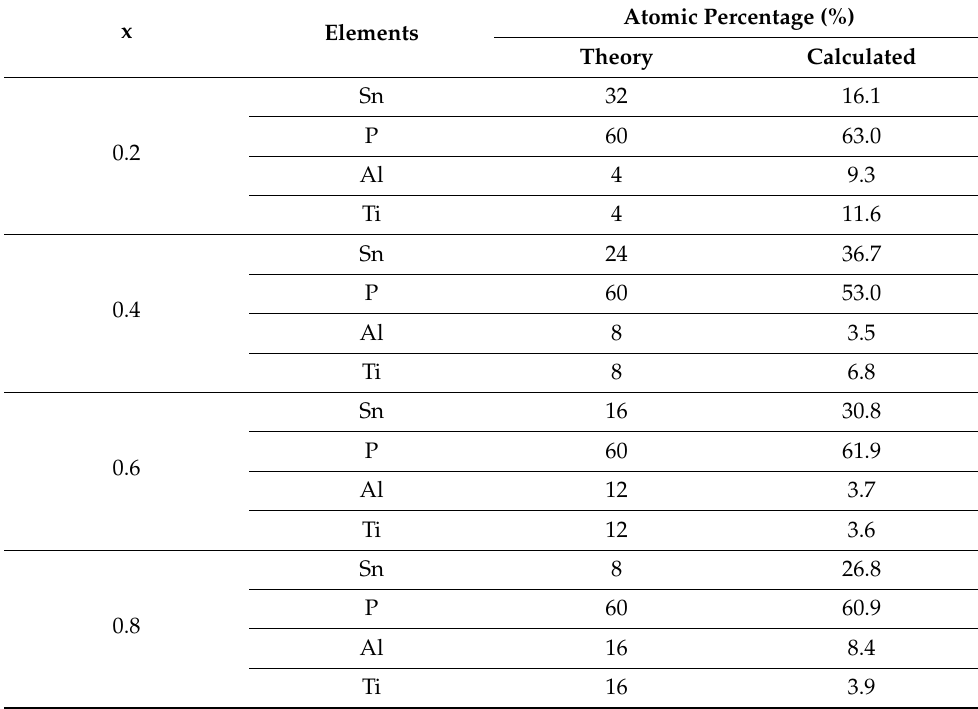
Table 3. Average value of atomic percentages of elements for all electrolytes at 650 ◦ C.